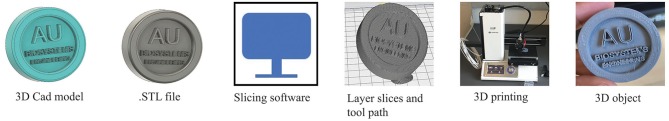
Process of 3D printing (Campbell et al., 2011; Wimmer et al., 2015).